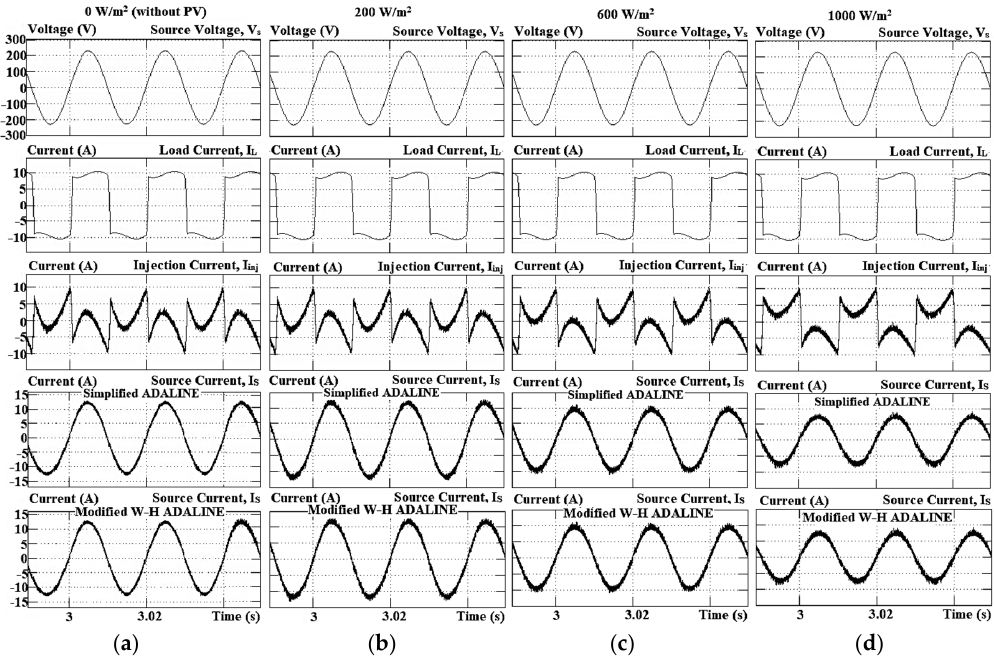
Figure 7. Simulation results which cover source voltage V s , load current I L , injection current I inj , and source current I s using both current harmonics extraction algorithms for ( a ) 0 W/m 2 (without PV), ( b ) 200 W/m 2 , ( c ) 600 W/m 2 , and ( d ) 1000 W/m 2 .